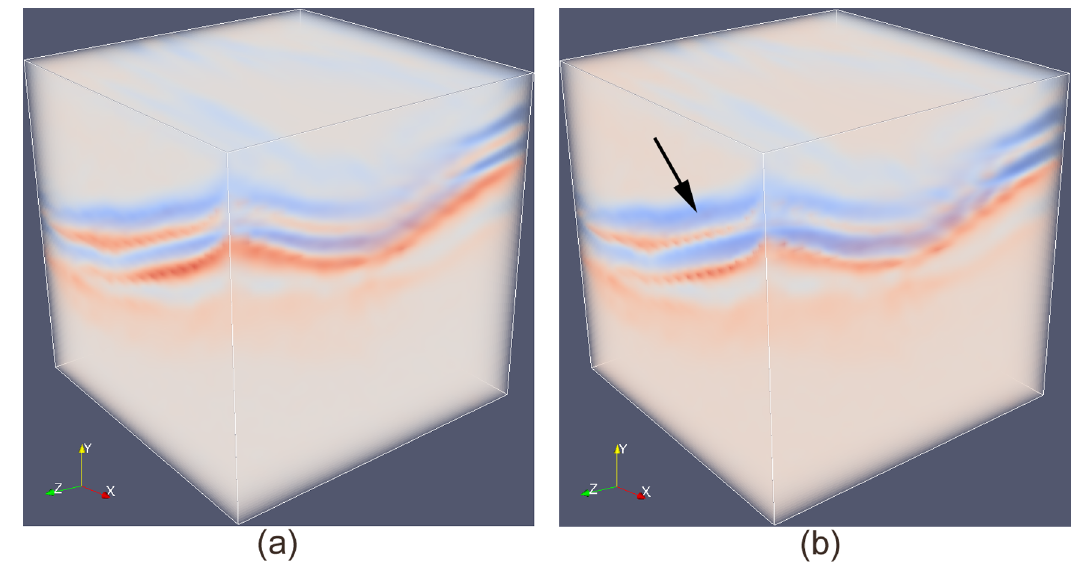
Figure 7. Node density is higher around target surface after non-Euclidean deformation by stretching area of interest as the one indicated by an arrow. (a) Original cost volume, where red voxels indicate high costs while blue voxels indicate low costs; (b) Cost volume after non-Euclidean deformation.